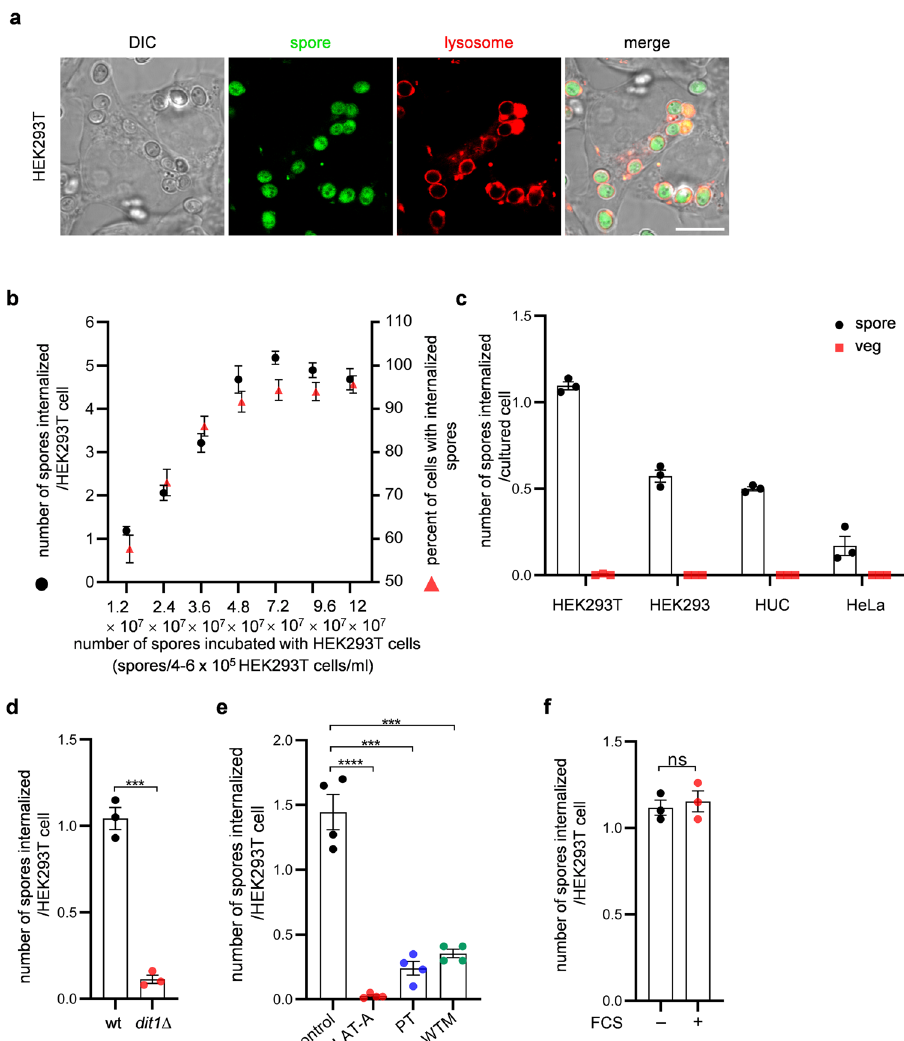
Fig. 1 Spores are internalized by NPPs. a Representative images of HEK293T cells with internalized spores expressing GFP was obtained with differential interference contrast (DIC) or fl uorescence microscopy (spore and lysosome). HEK293T cells were incubated with spores at 3.6 × 10 7 spores/4 – 6 × 10 5 HEK293T cells/ml. Lysosomes were stained with LysoTracker Red. Scale bar, 10 µ m. b Numbers of spores internalized per HEK293T cell (black circles) and percentages of HEK293T cells with internalized spores (red triangles). HEK293T cells were incubated for 1 h with various quantities of spores in